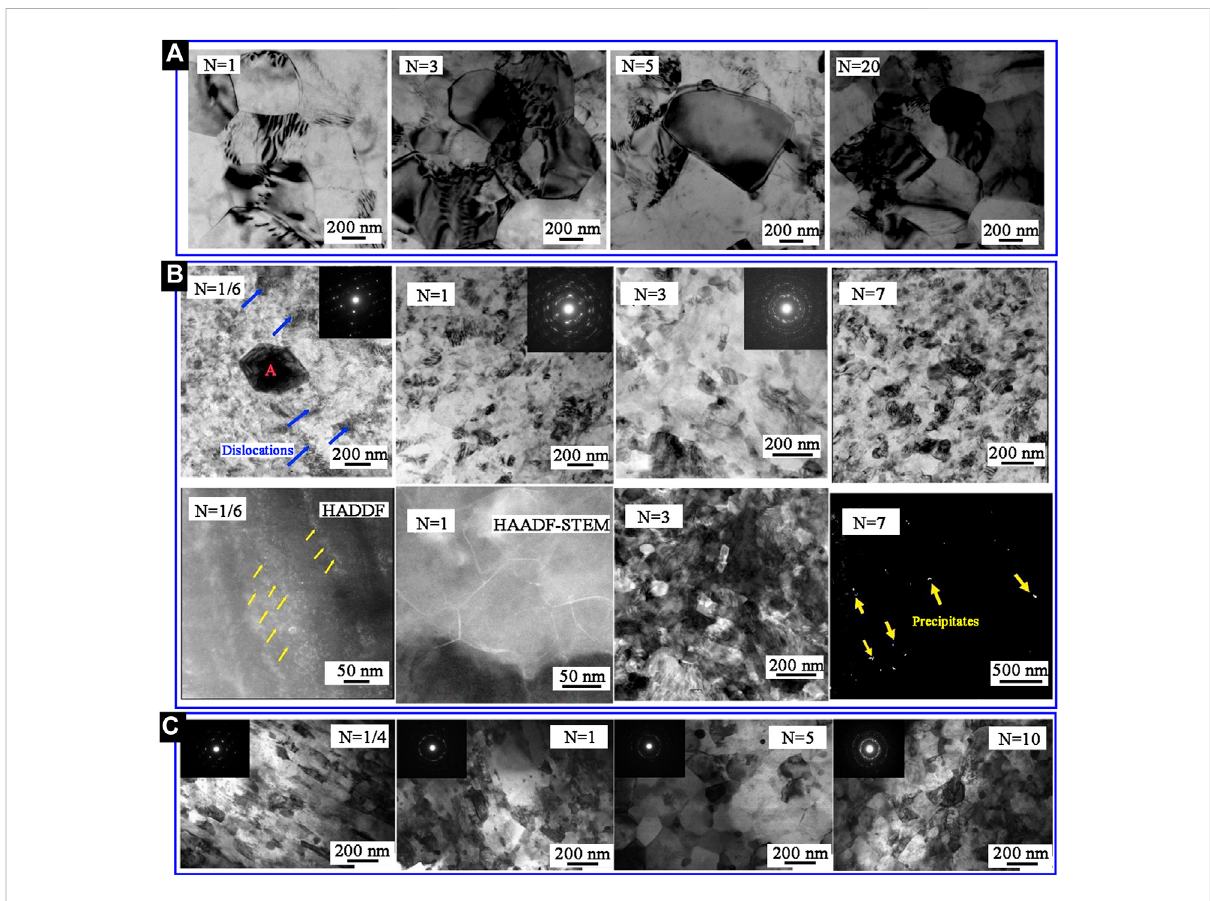
FIGURE 4 Ultra fi ne-grained structures processed by HPT process for (A) pure Mg (Gu et al., 2018), (B) AZ31 alloys (Li Y. S. et al., 2020), and (C) AZ80 alloys (Alsubaie et al., 2016) through different